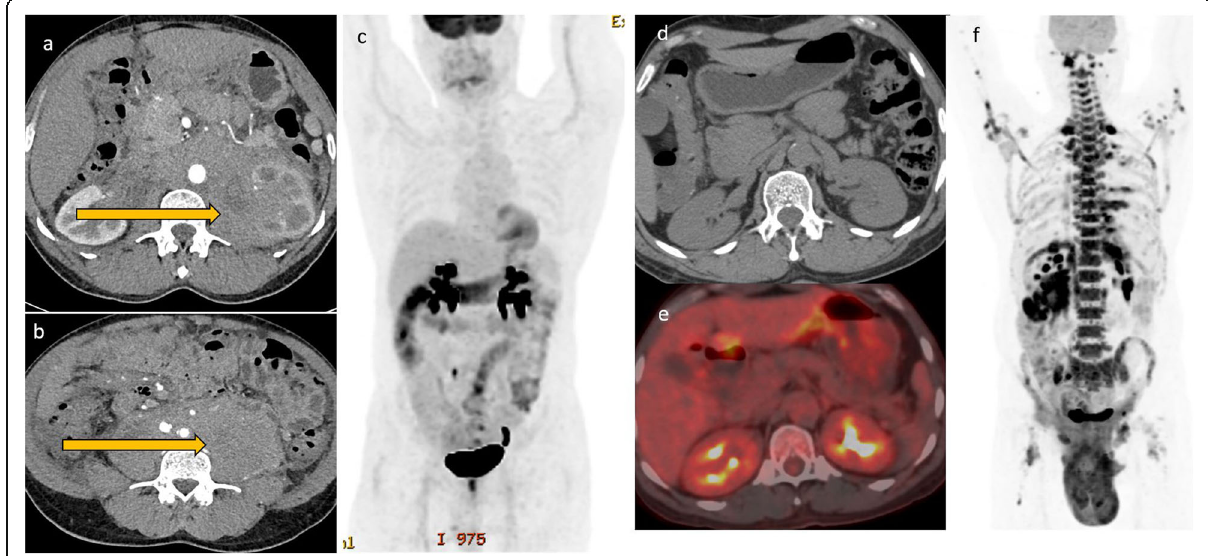
Fig. 9 This patient with extensive retroperitoneal and renal disease ( a and b ) showed excellent response to treatment in the interim PET CT ( c , d , and e ) after two cycles of R-CHOP. There was however early relapse with bulky disease developing in the retroperitoneum and the scrotum ( f )